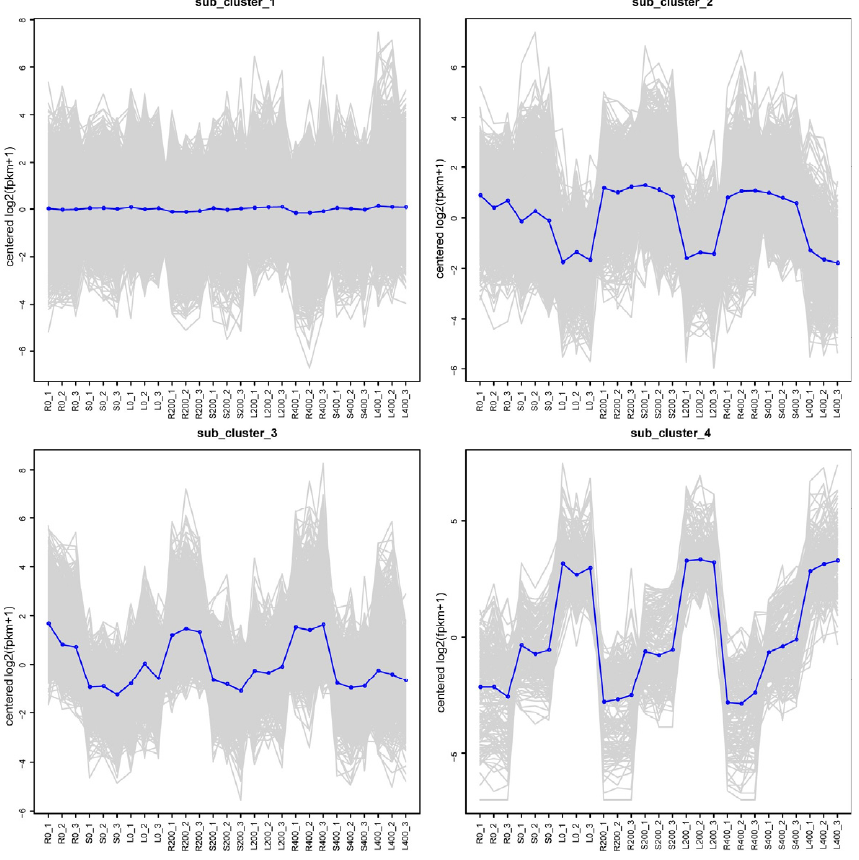
Figure 6. Trend analysis.